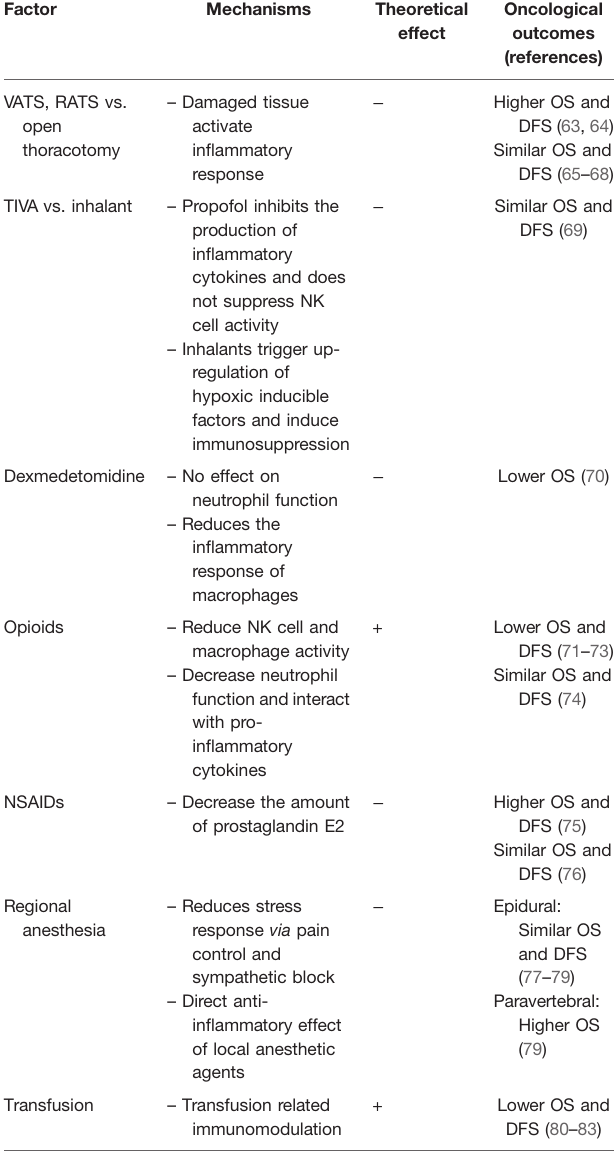
TABLE 2 | Perioperative factors that in fl uence the in fl ammatory response after surgery and their impact on oncological